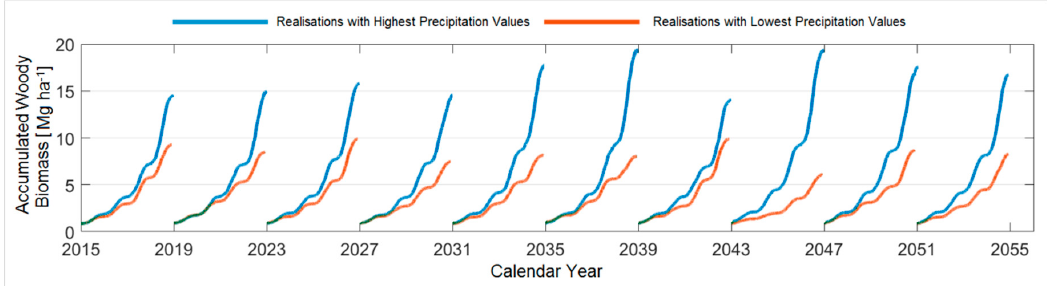
Figure 6. Projected woody biomass of black locust trees under special realisations describing either the highest precipitation values (blue) or the lowest precipitation values (orange) with respect to the ten established growing periods.